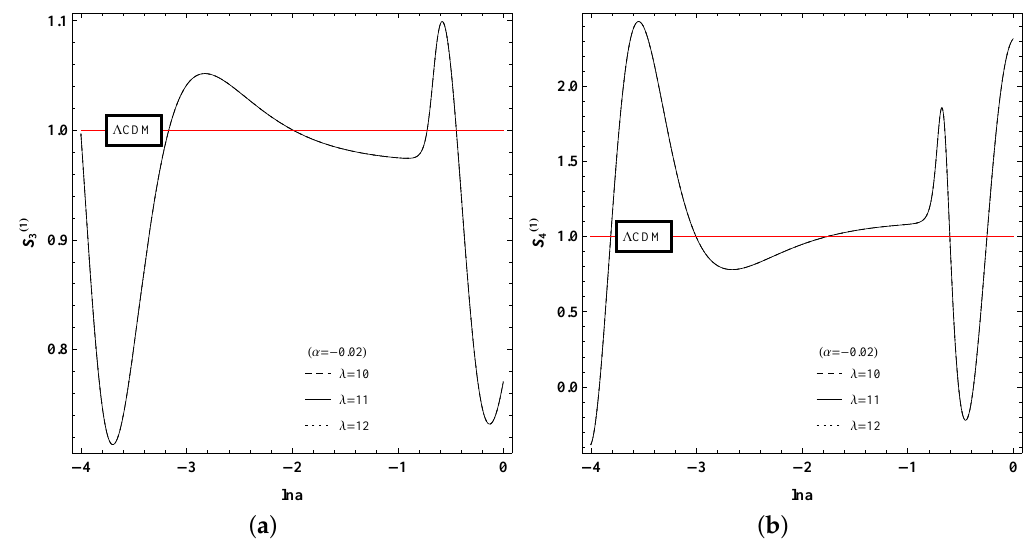
( 1 ) Figure 9. ( a ) Graph of S for P 3 with different parameters λ and fixed α = − 0.02. ( b ) Graph of S 3 for P 3 with different parameters λ and fixed α = − 0.02. The initial point is x 0 = 1, y 0 = 0.3.